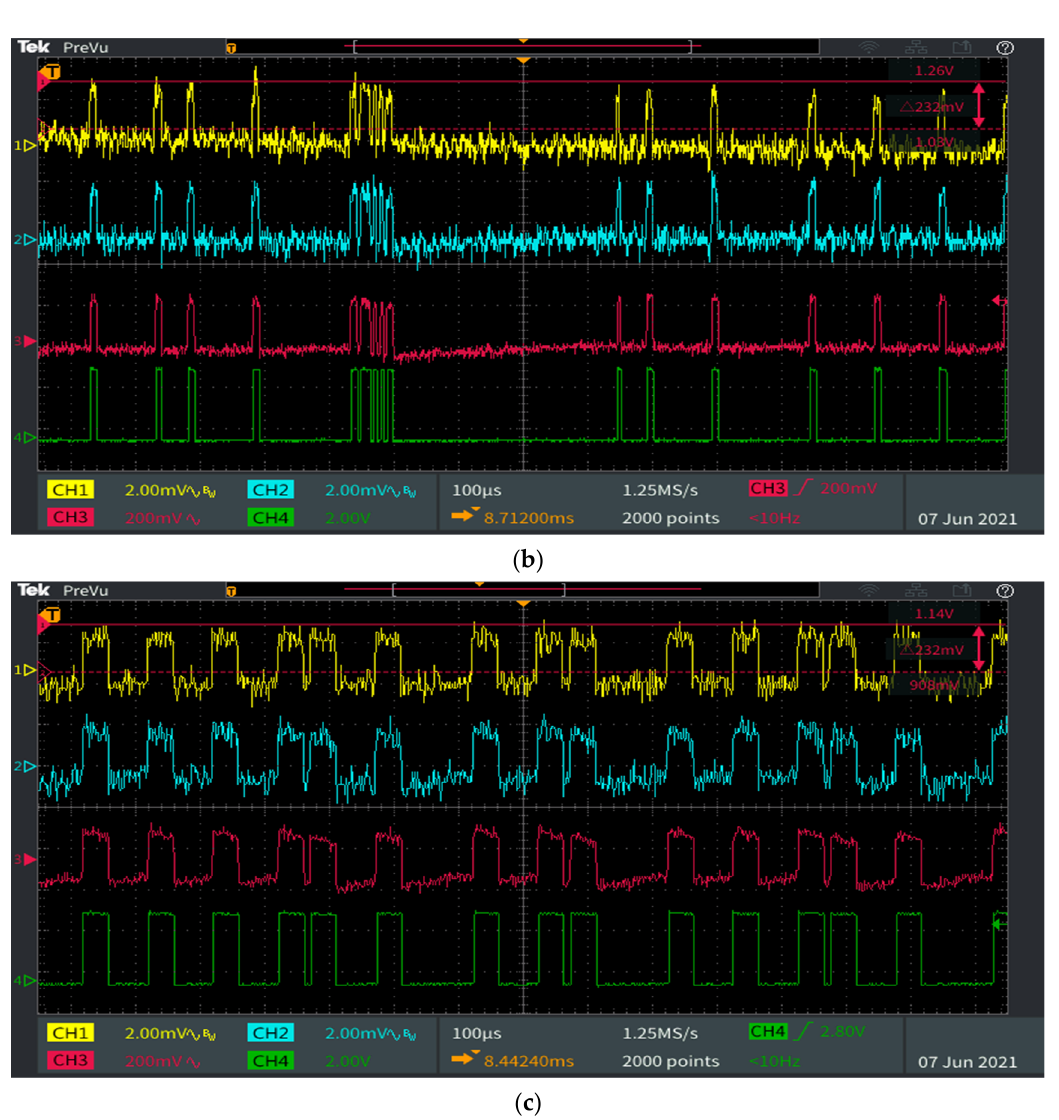
Figure 13. Oscilloscope print screens presenting the signal reconstruction process at the VLC receiver level: Channel 1 (yellow) contains the output of the optical receiver adjusted at 20 dB gain; Channel 2 (cyan) contains the output of the band-pass filter; Channel 3 (magenta) shows the output of the amplification blocks; Channel 4 (green) displays the reconstructed signal which is used for the data decoding process: ( a ) 1% duty cycle; ( b ) 10% duty cycle; ( c ) 40% duty cycle.